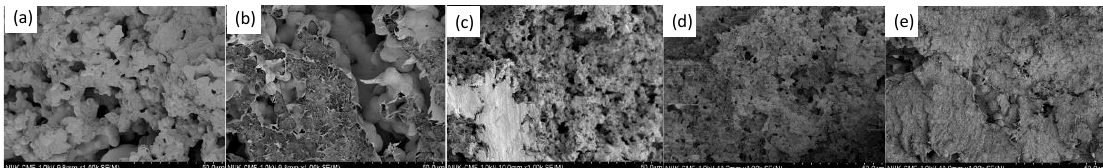
Figure 1. SEM images of phenoxy/PBT blends (1000 × ): ( a ) phenoxy/PBT = 1/9, ( b ) phenoxy/PBT = 3/7, ( c ) phenoxy/PBT = 5/5, ( d ) phenoxy/PBT = 7/3, and ( e ) phenoxy/PBT = 9/1.